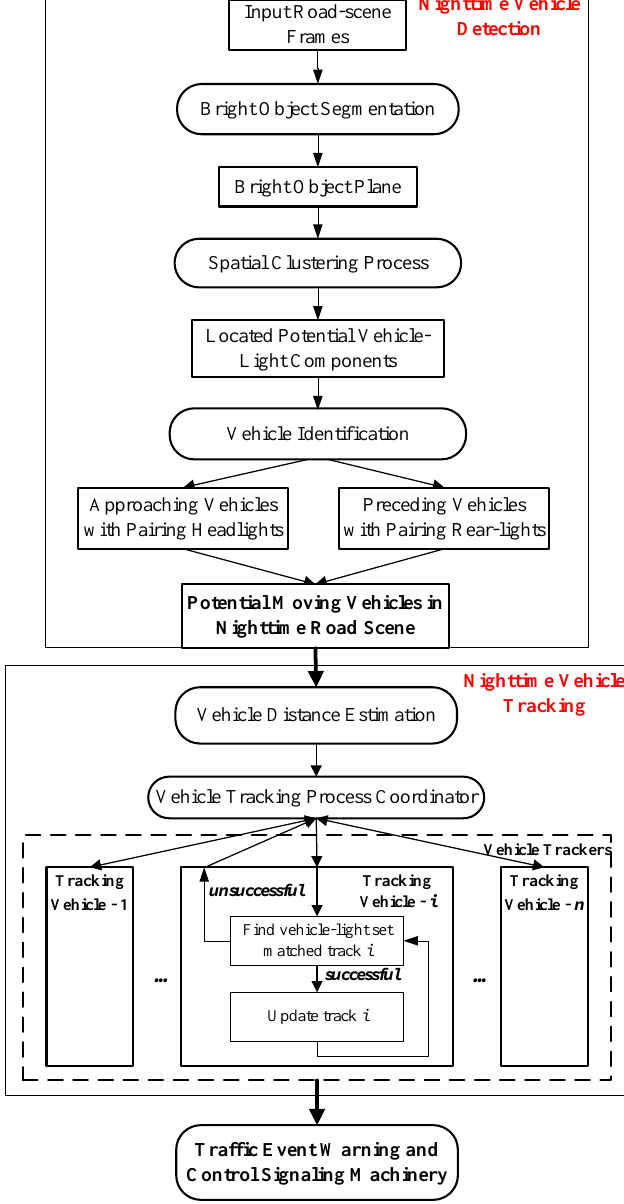
Figure 1. System block